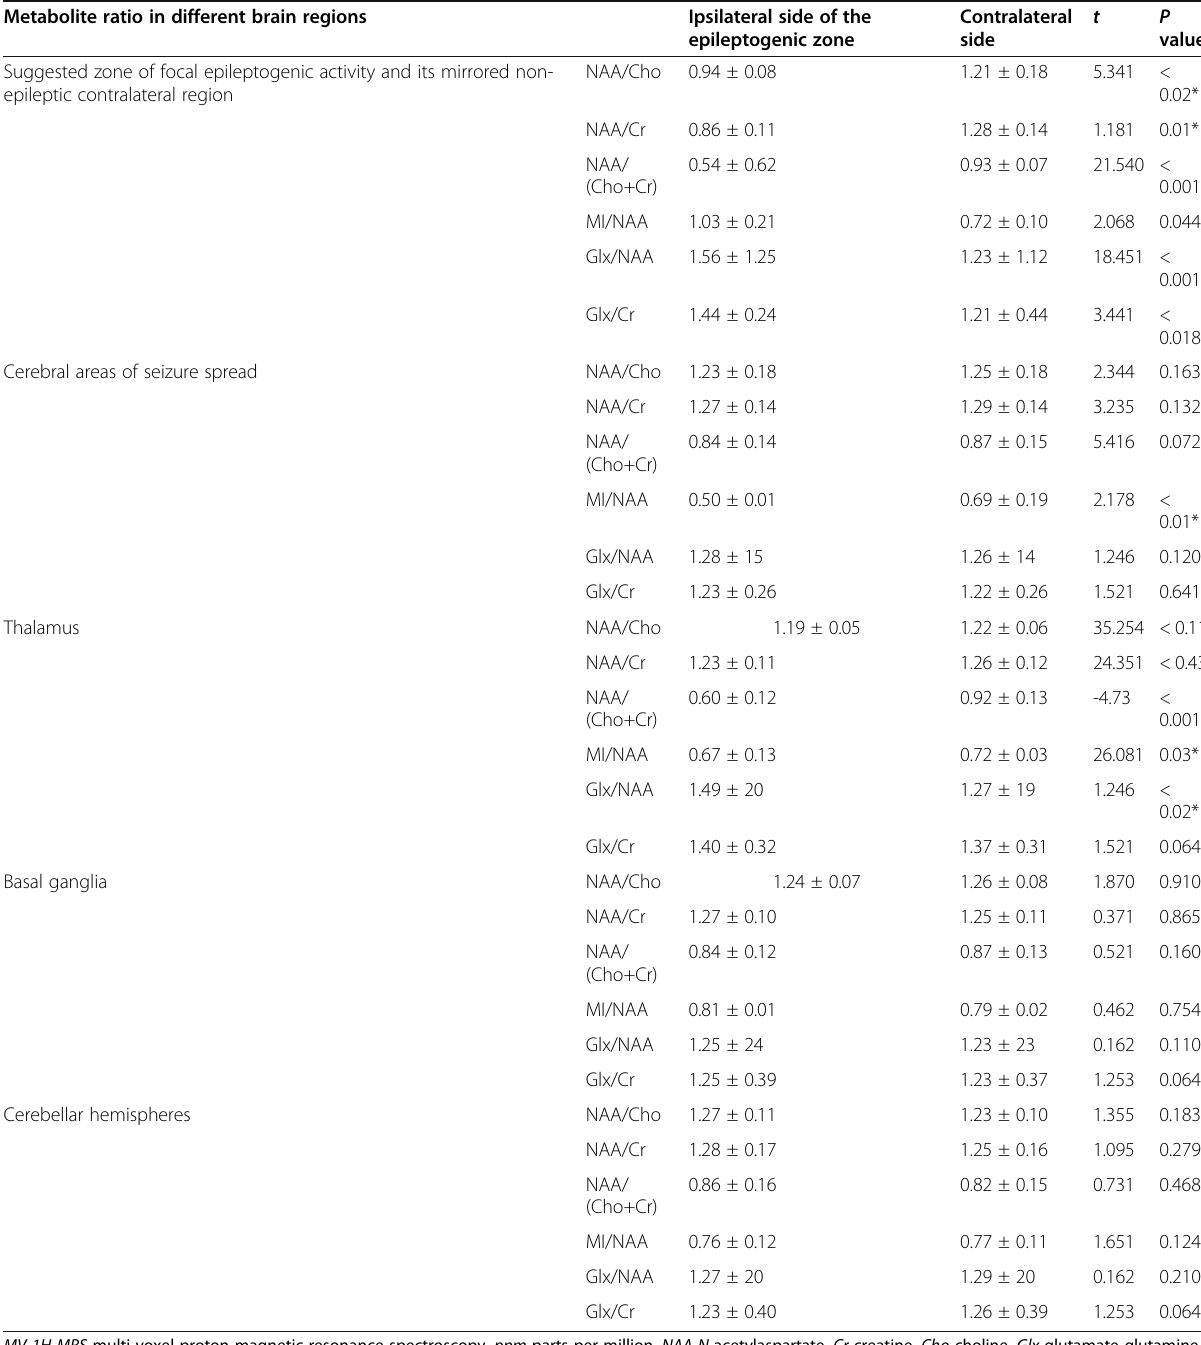
Table 5 The mean metabolite concentration ratios in brains of the studied patients ( n =